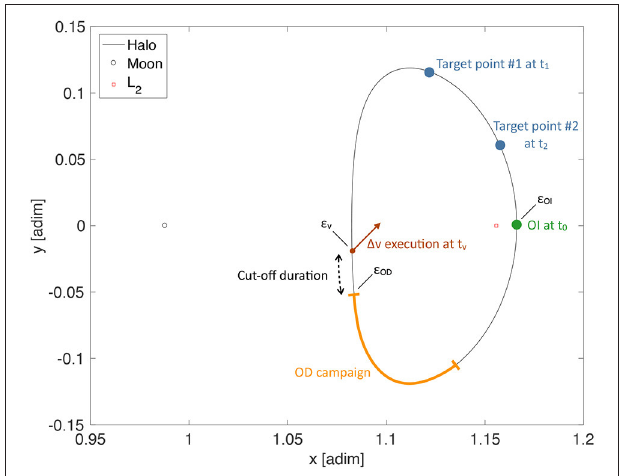
FIGURE 8 | Overview of S/K simulation process and target points method.